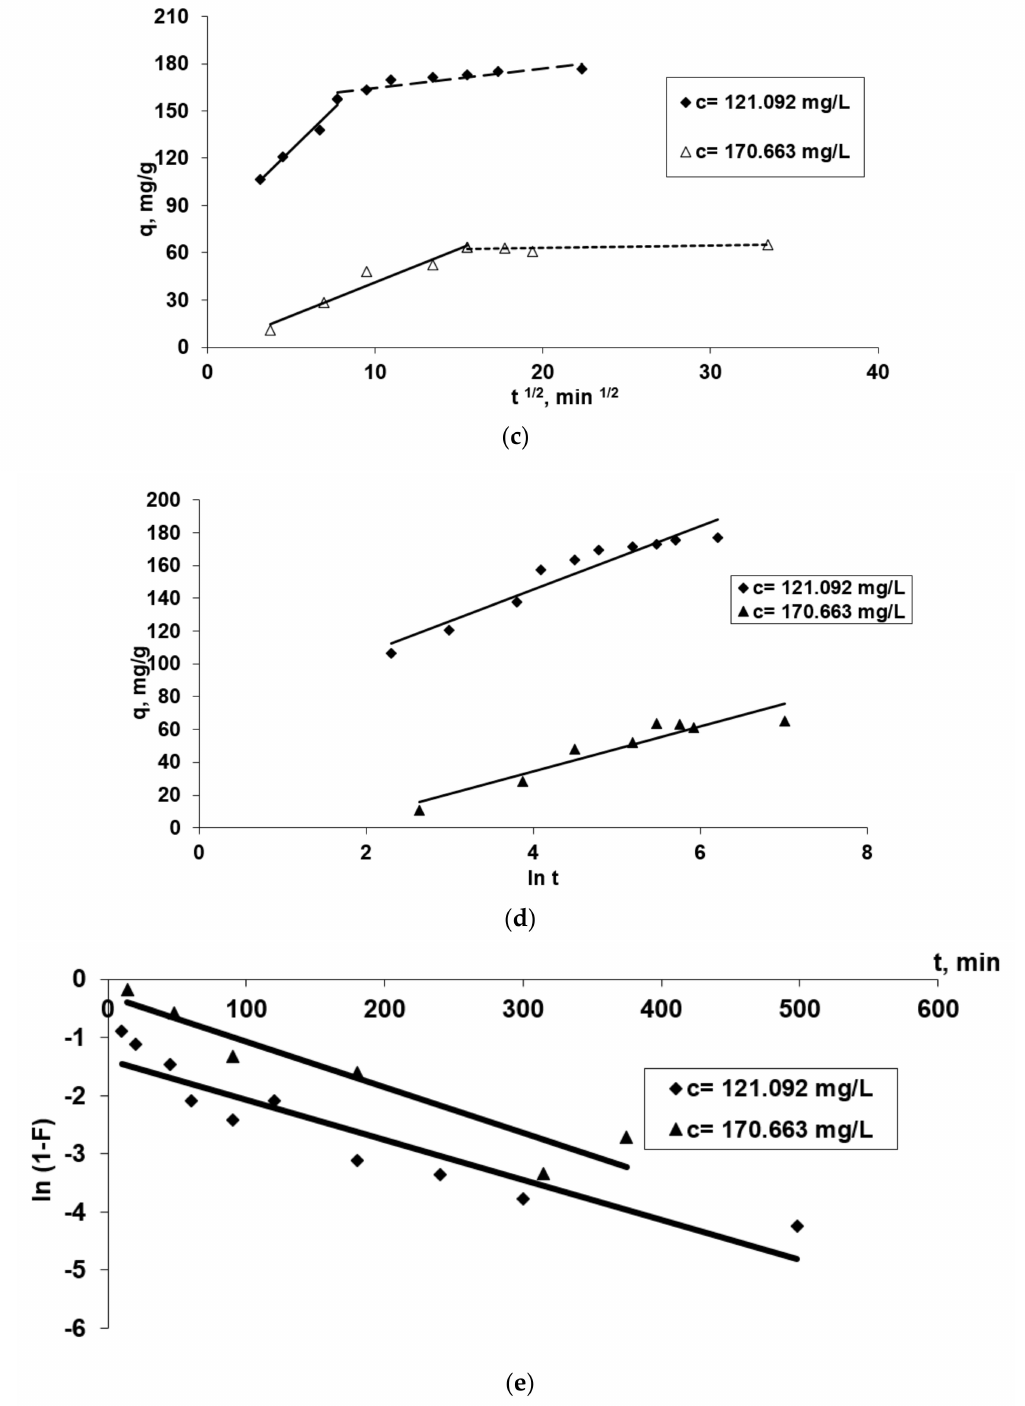
Figure 7. The applicability of some kinetic models [Pseudo-first order and pseudo-second order diffusion kinetic ( a , b ), Webber ( c ), Elovich ( d ) and McKay ( e )] in the Co 2+ (bio)sorption onto OxC25 hydrogel. Operational conditions: biosorbent concentration of 0.4 g/L; pH = 1.5; temperature of 20 ◦ C; two initial concentrations of Co(II) solution (C Co2+ = 121.092 mg/L, or 170.663